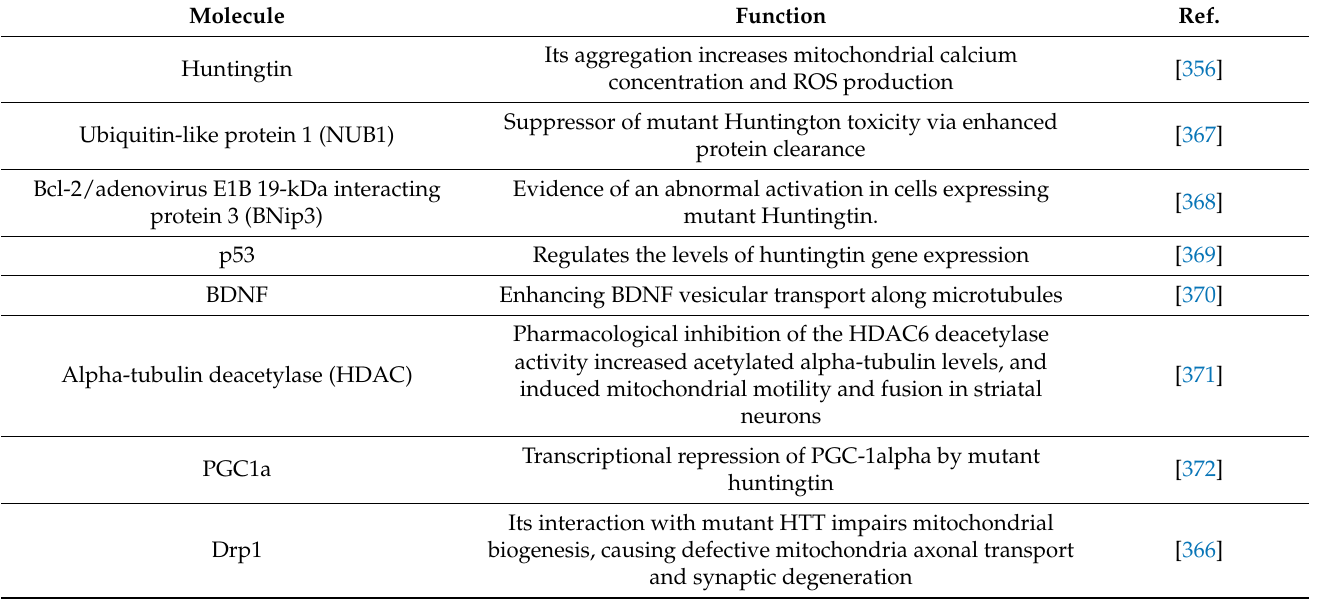
Table 7. Proteins involved in mitochondrial dysfunction in Huntington